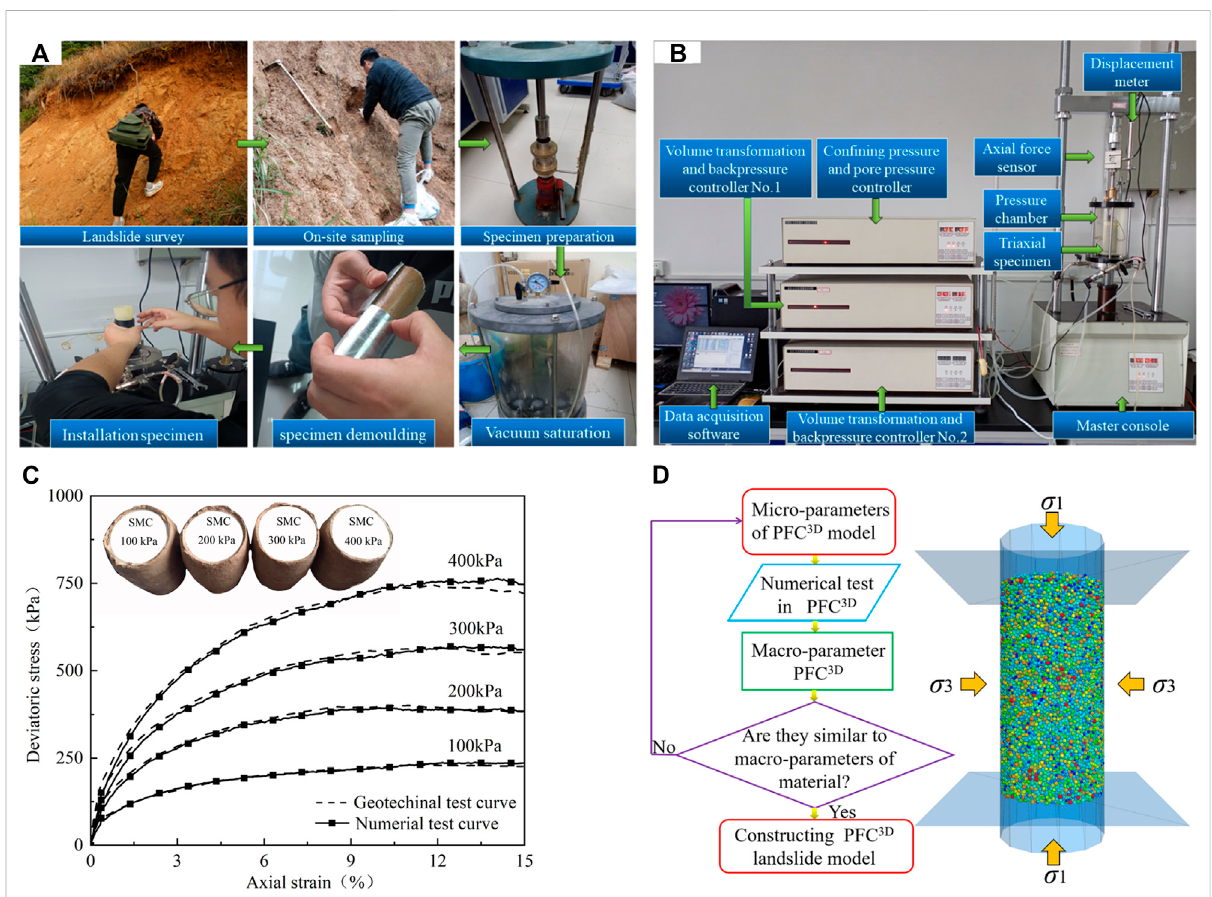
FIGURE 4 Themacro-strengthtestandmicro-strengthparameterscalibrationoflandslidematerials: (A) materialcollectionandspecimenpreparation; (B) triaxial compression test in laboratory; (C) stress-strain curves of landslide materials; (D) the fl ow chart of numerical triaxial compression and micro- parameters